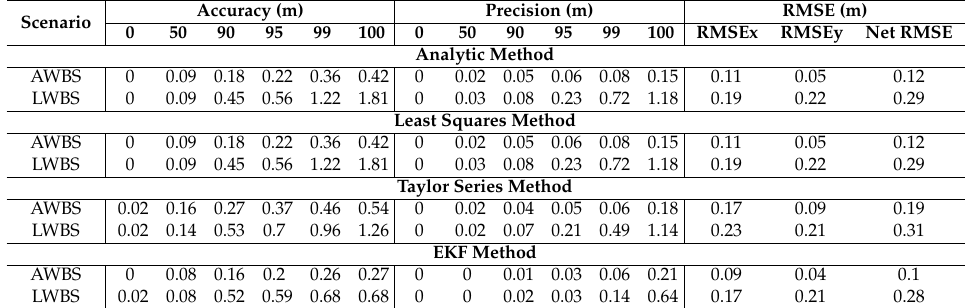
Table 3. Performance comparison of the localization algorithms for the metrics accuracy, precision, and RMSE. All localization algorithms are compared for both atrium and lab scenarios and without human body interference.